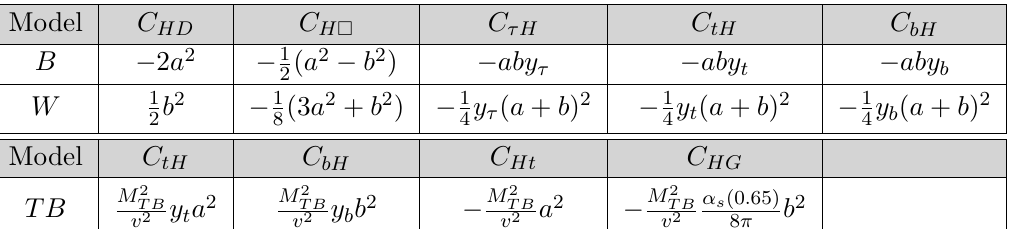
Table 5 . Operator coefficients generated by the tree-level single-field models B , W and TB , which each depend on two couplings a and b , with y couplings respectively, v denoting the electroweak scale and α coefficients of all operators are proportional to the corresponding entries in the table and divided by M 2 .